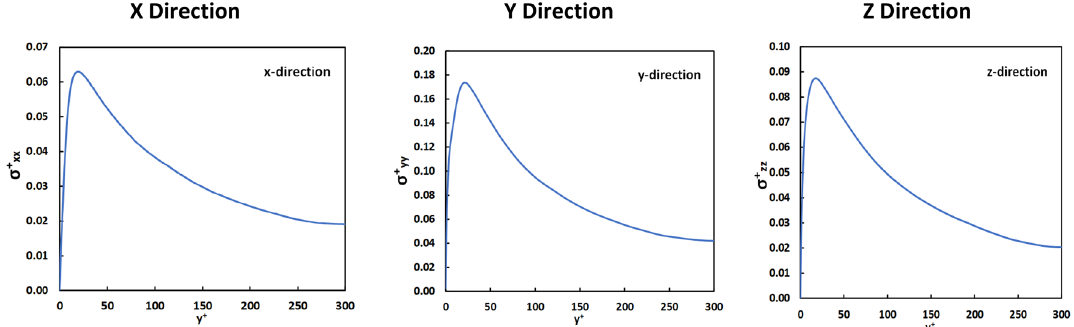
Figure 5. Eulerian average of the absolute value of the extensional stress as a function of the distance from the wall in plane Poiseuille flow. Since the Poiseuille flow channel is symmetric across the center place at y + = 300, only the bottom half of the stress profile is presented.